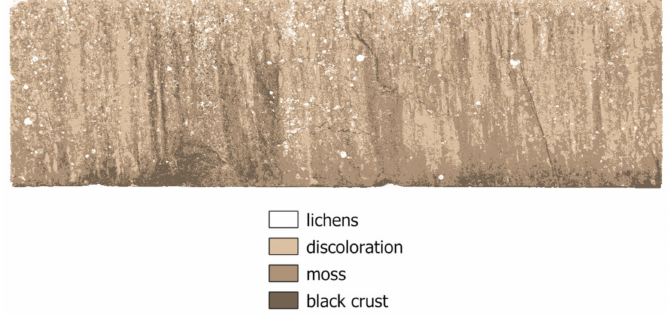
Figure 14. Degradation map, cubic stone pedestal at the Temple of Athena and Zeus Sotiros.